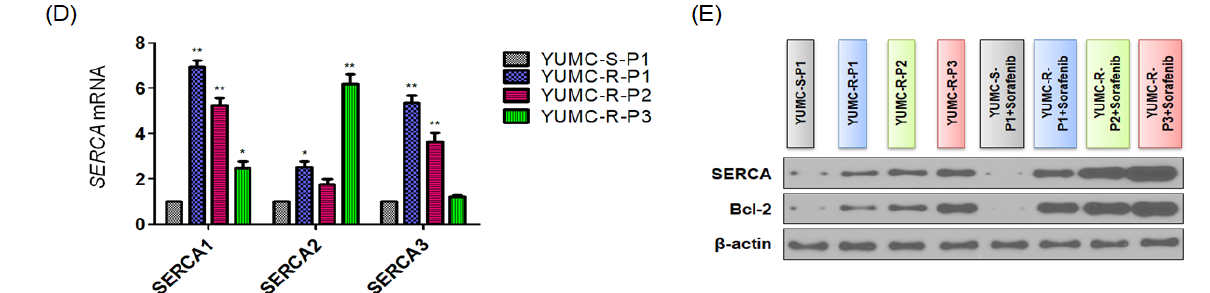
Figure 1. Features of all investigated papillary thyroid cancer (PTC) cell lines. ( A ) Hierarchical clustering of genes indicating divergent gene expression and gene expression profile changes between human sorafeni-sensitive and -resistant PTC cells. ( B ) Analysis of gene expression level based on mRNA-Seq for epithelial–mesenchymal transition (EMT), fibroblast growth factor (FGF)/FGF receptor, and cancer stem cell (CSC) markers in sorafenib-sensitive and -resistant PTC cells. ( C ) Bar plot revealing remarkably increased expression of 15 signaling pathways in soraenib-resistant PTC cells, YUMC-R-P1 ( Left ), YUMC-R-P2 ( middle ), and YUMC-R-P3 ( Right ). ( D , E ) Expression levels of SERCA RNA and protein in sorafenib-sensitive and -resistant PTC cells in the absence and presence of sorafenib treatment. * p < 0.05 vs. sorafenib-sensitive PTC cells (YUMC-S-P1), ** p < 0.01 vs. sorafenib-sensitive PTC cells (YUMC-S-P1).